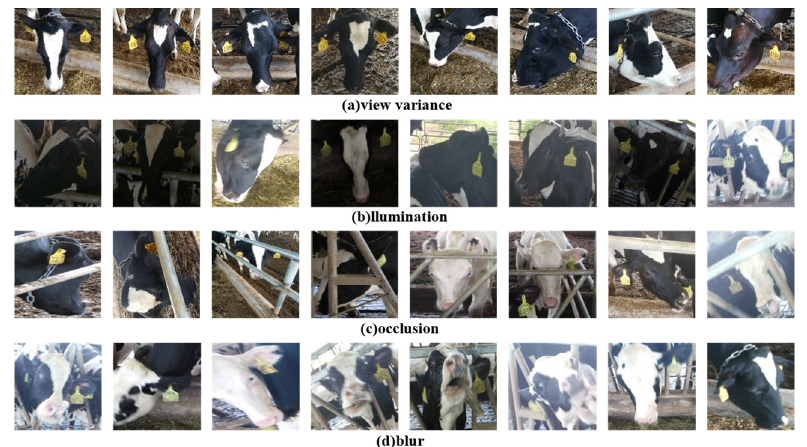
Figure 2. Data distribution of cow face dataset.